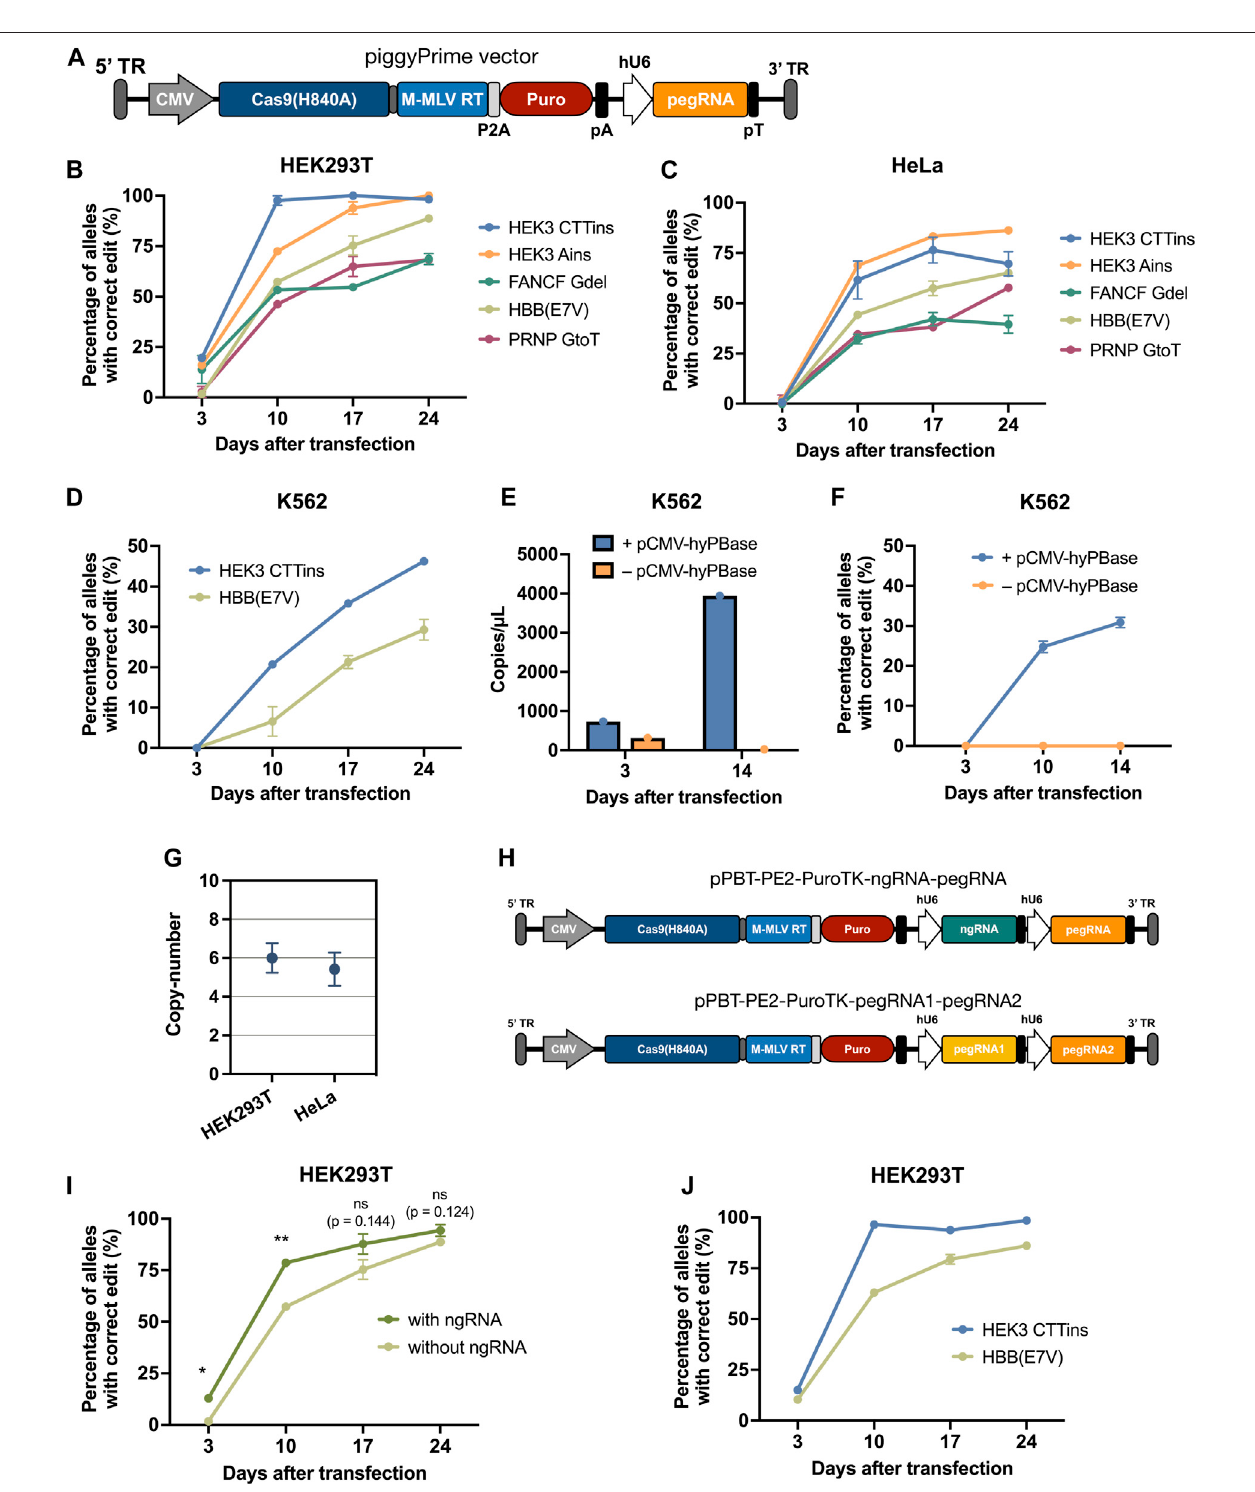
FIGURE2| |Effective primeeditingbypiggyBac-mediatedintegrationofallprime editingcomponents usingasingle-vector system. (A) Schematicoverviewofthe piggyPrime vector, consisting of (from the right) a 5 ’ terminal repeat (TR), CMV promotor, Cas9(H840A)-linker-M-MLV-RT (PE2), P2A, PuroR, bGH pA, hU6 promotor, pegRNA, and 3 ’ TR. (B,C) Integration of piggyPrime vectors containing the HEK3-CTTins, HEK3-Ains, HBB(E7V), FANCF-6Gdel, and PRNP-GtoT pegRNAs into HEK293T (B) and HeLa (C) cells resulting in increasing correct editing at target sites over time. Puromycin was applied at day 3 after transfection. (D) piggyPrime vectors can also successfully be integrated into the genome of K562 cells by transfection, resulting in increased correct editing over time. (E) pegRNA levels were